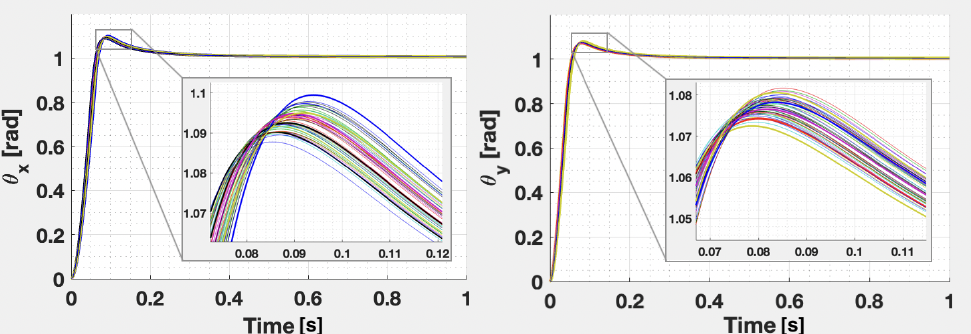
Figure 6. The step responses of the nominal closed-loop system, along with 50 Monte Carlo simula- tions for X axis ( left ) and Y axis ( right